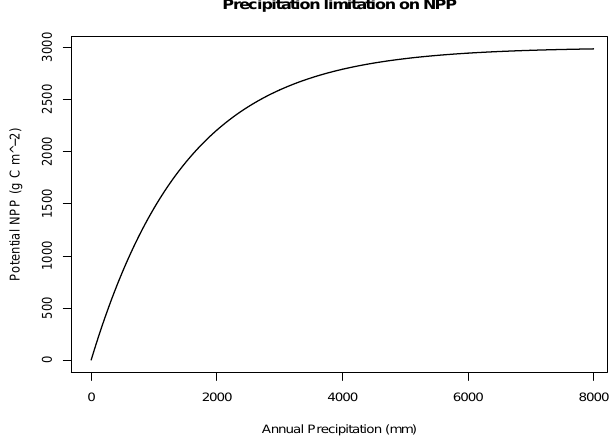
Figure 1. Lieth’s net primary production (NPP) model describing potential NPP (gCm − 2 yr − 1 ) as a function of annual